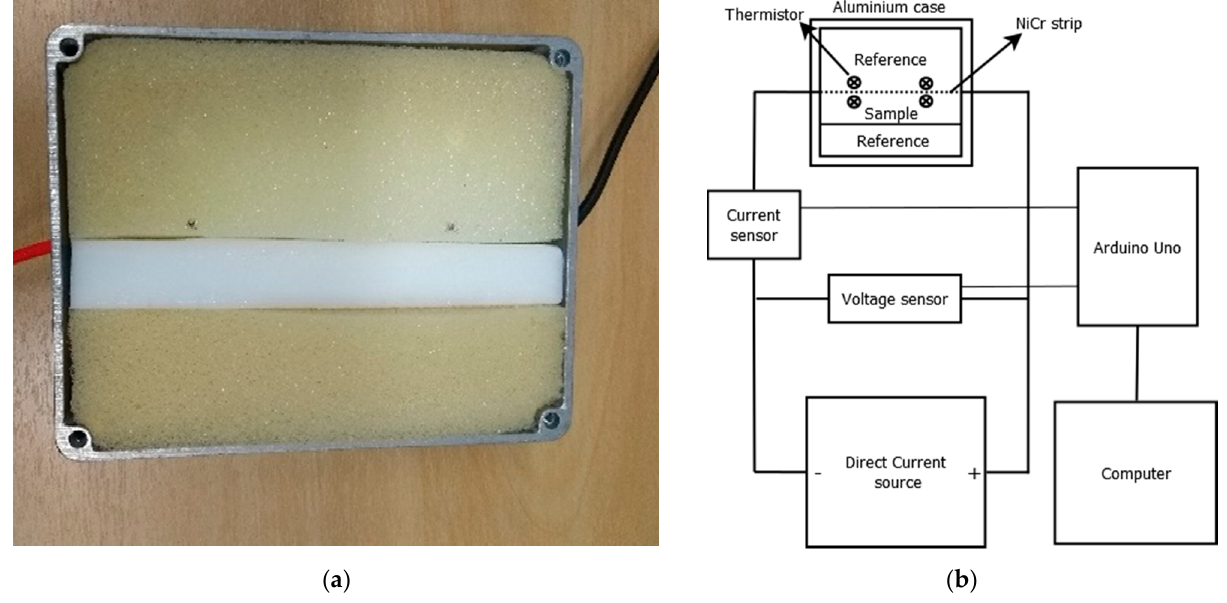
Figure 11. ( a ) Top-view of the aluminum case (open) filled with the sample and the reference (PU) and ( b ) the schematic representation of the experimental setup. There were four thermistors that were also connected to the Arduino Uno board. The dotted line represents the NiCr strip.